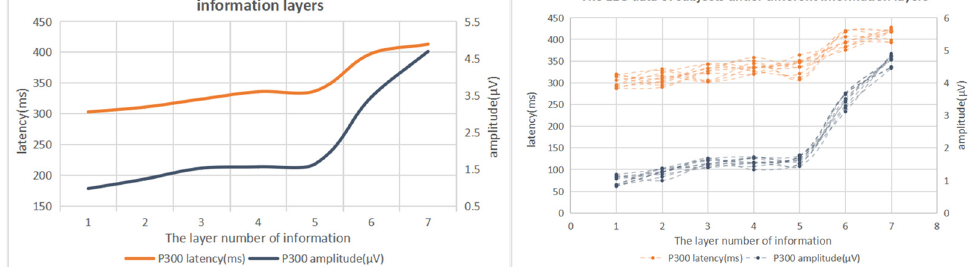
Figure 17. Variation trend of the P300 amplitude and latency of subjects under different numbers of information layers.